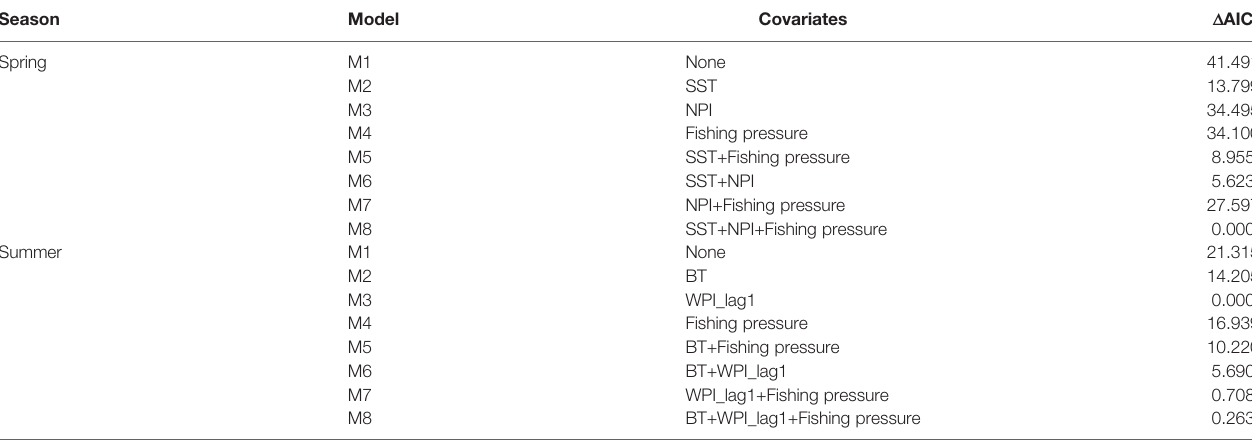
TABLE 2 | Model selection based on Akaike ’ s information criterion (AIC) for the eight alternative spatio-temporal delta-Gamma models in spring and summer, respectively fi tted in the present study.